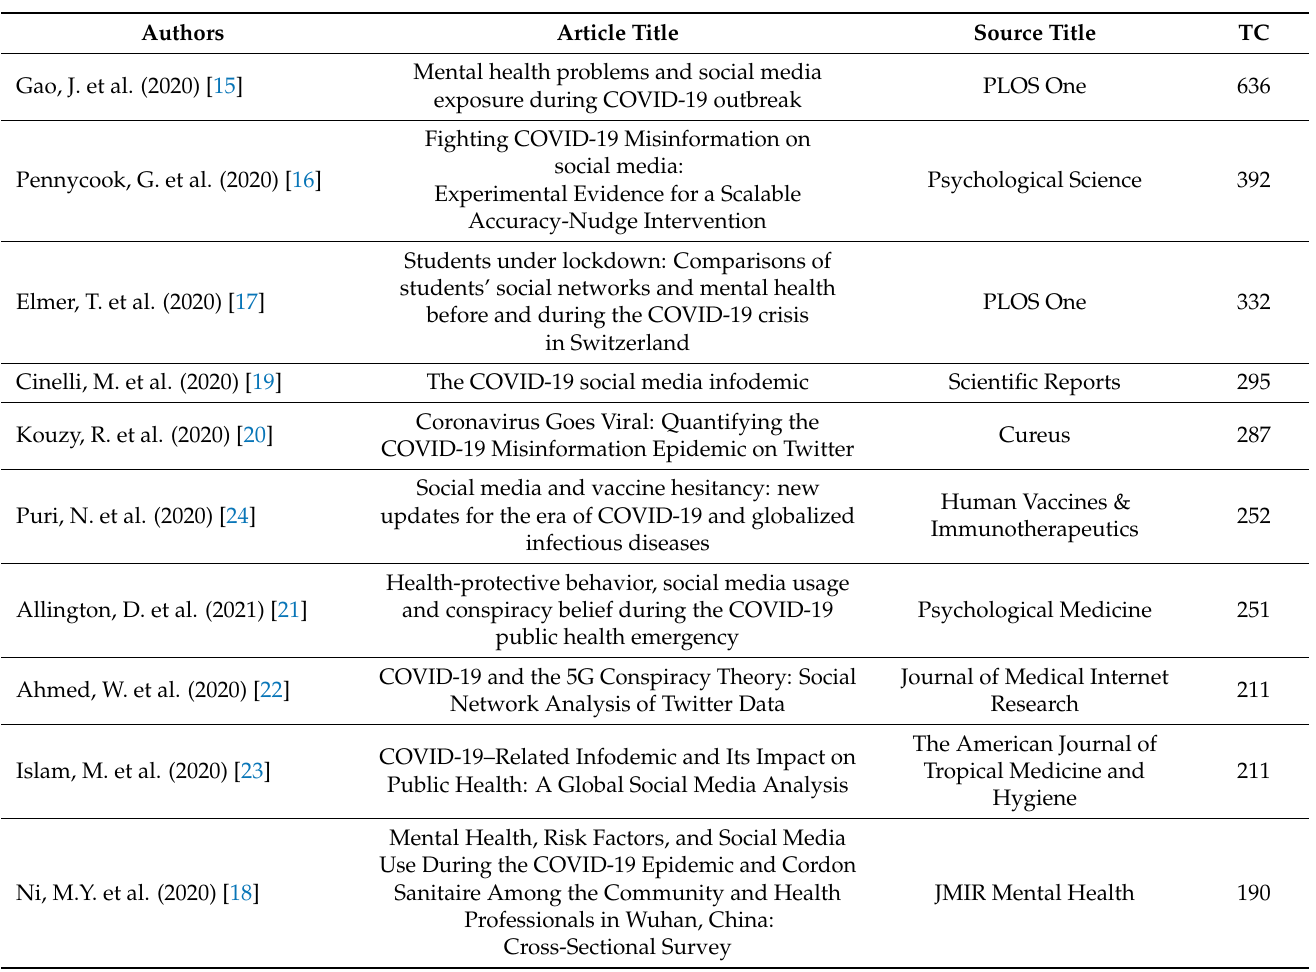
Table 7. Top 10 research articles by total